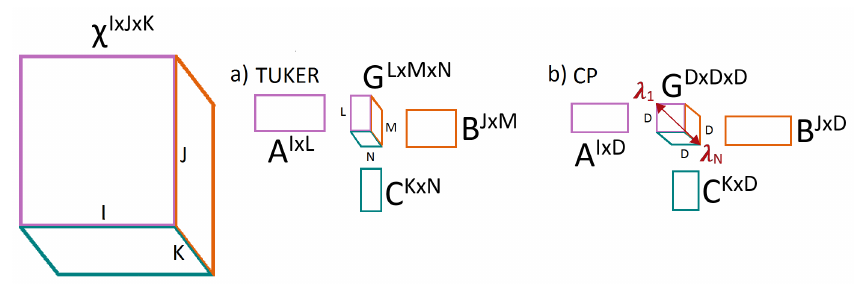
Figure 2. Diagram of the tensor decompositions used. ( a ) Tucker ( b ) CANDECOMP/PARAFAC